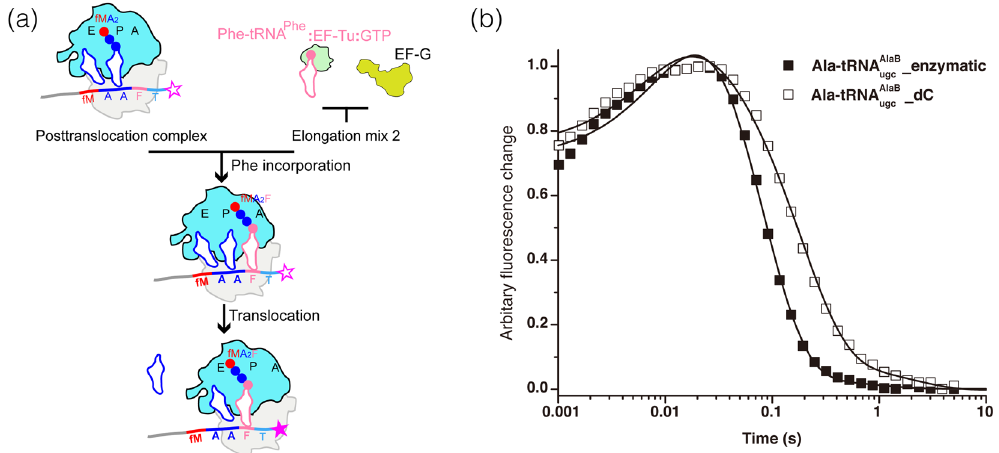
Figure 5. Assay of translocation of tRNA Ala from ribosomal P- to E-site. ( a ) Schematic of stopped-flow experiment. Post-translocation complex programmed with 3 ′ pyrene-labeled mMAAFT and fMA 2 -tRNA Ala in the P site was mixed with elongation mix 2 containing Phe-tRNA Phe and EF-G on a stopped-flow apparatus. After the very fast fMA 2 F-tRNA Phe formation, the tRNAs were translocated from A and P sites to P and E sites with concomitant moving of the 3 ′ end of the mRNA towards the ribosome, leading to quenching of the pyrene fluorophore fluorescence (shown as an open star turning to a filled star). ( b ) Comparison of the representative time courses of P- to E-site translocation of tRNA Ala in the experiments done with Ala-tRNA AlaB ugc _enzymatic (filled squares) and Ala-tRNA AlaB ugc _dC (open squares). For better comparison, a digital filter was used to reduce the noise and the number of data points in the traces and time courses were normalized with the maximum value in each curve as 1 and the minimum value as 0. Solid lines represent the fitting of the traces to a double-exponential model. Experiments were conducted at least in duplicates (see text for standard